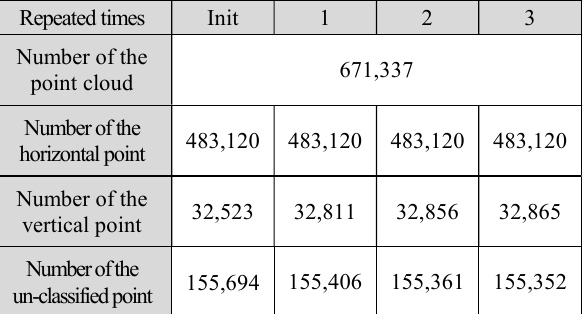
Figure 3. Mesh modelling process using proposed method